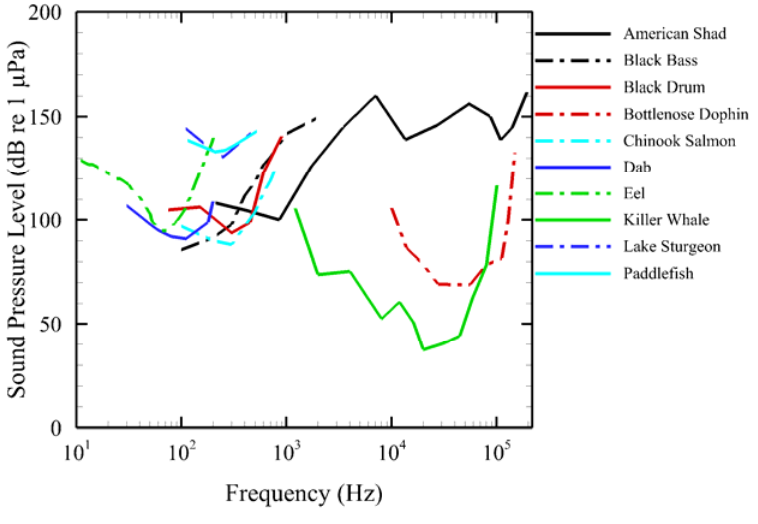
Figure 3. Audiograms of the 10 species of fish and marine mammals in the AAMI audiogram library